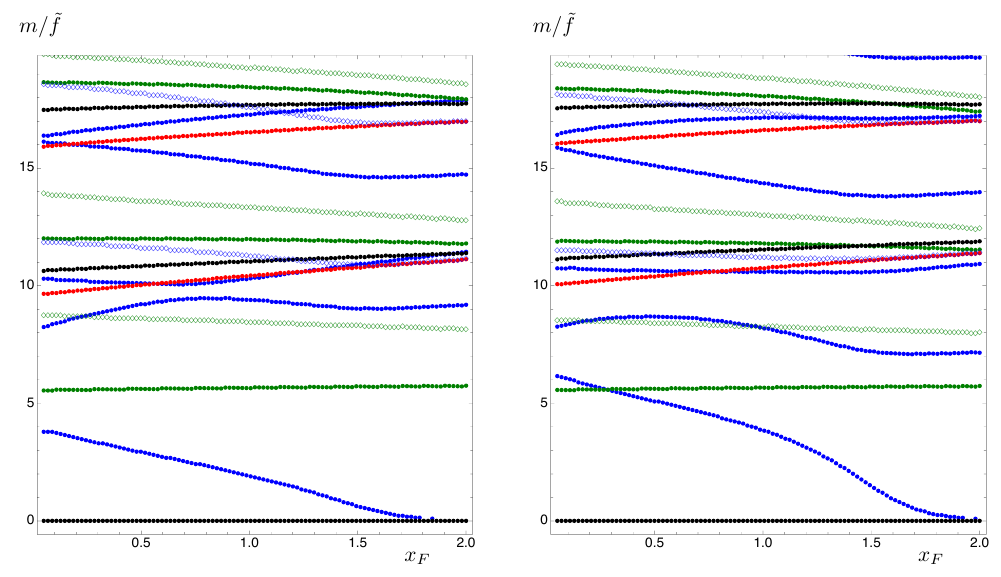
Figure 16 . Model IIA (left) and IIB (right). Spectrum as a function of x F for ∆ = 3 , ∆ φ = 1 , g 5 = 5 , ρ 1 = − 13 , ρ 2 = 8 , and φ A = 2 (Model IIA, left), φ B = 0 . 9 (Model IIB, right), normalized √ to the decay constant ˜ f ≡ f/ N C . The colour coding for the spectrum is: singlet scalar (blue), non-singlet scalar (blue diamonds), tensor (red), pseudoscalar (black), vector (green), axial-vector (green diamonds).